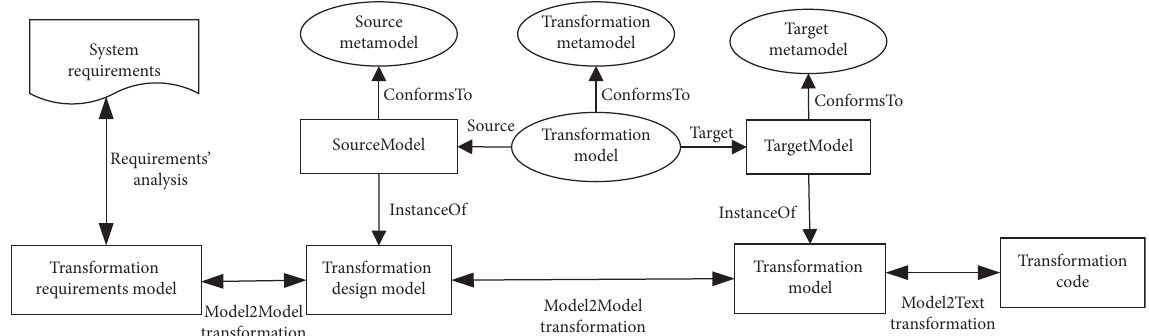
Figure 1: Modeling process and transformations in